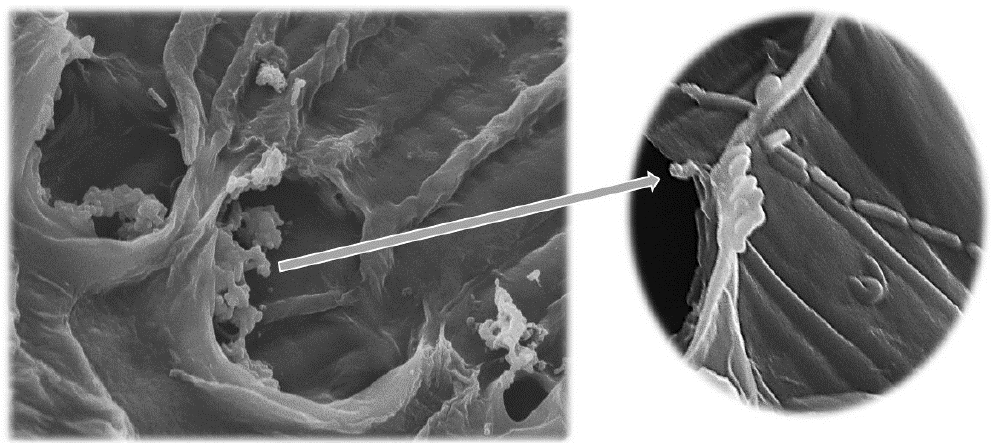
Figure 4. Electron micrographs of the freeze-dried immobilized on DWB L. paracasei K5 (left: × 30 µ m and right × 10 µ m).